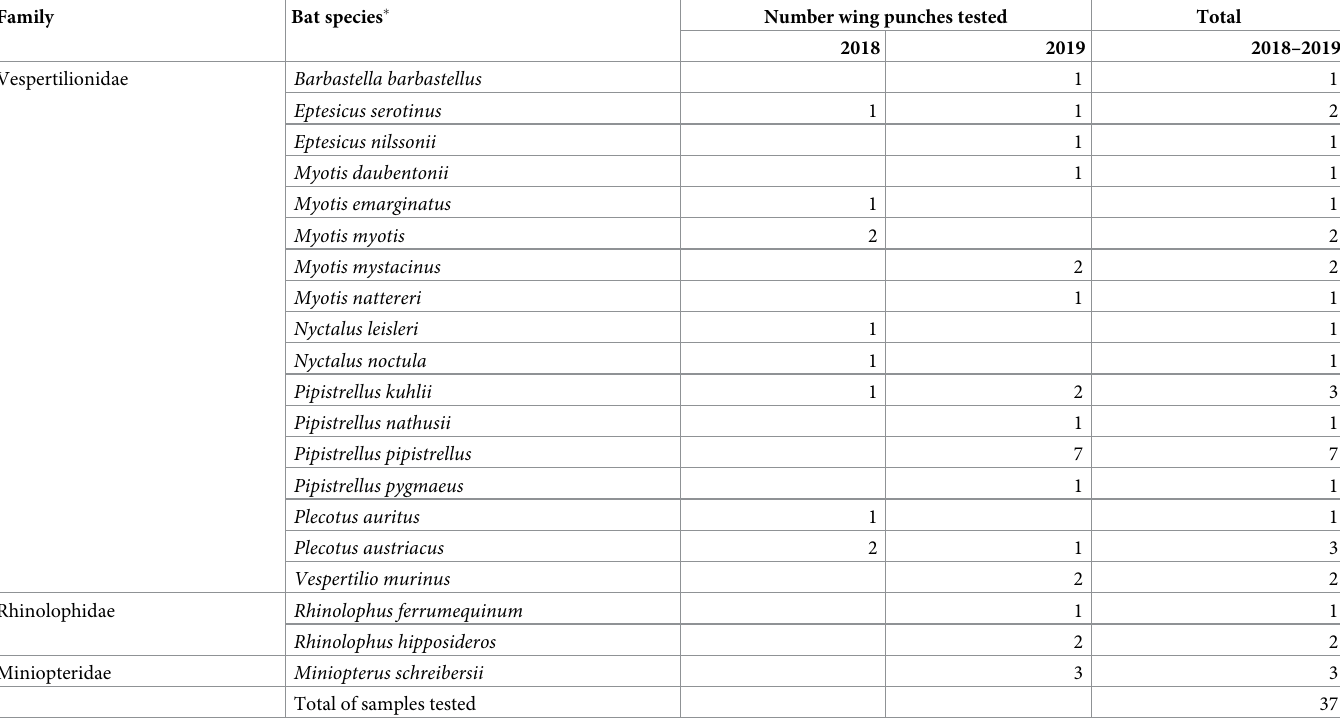
Table 2. Characteristics of the 37 bat carcasses included for optimization.